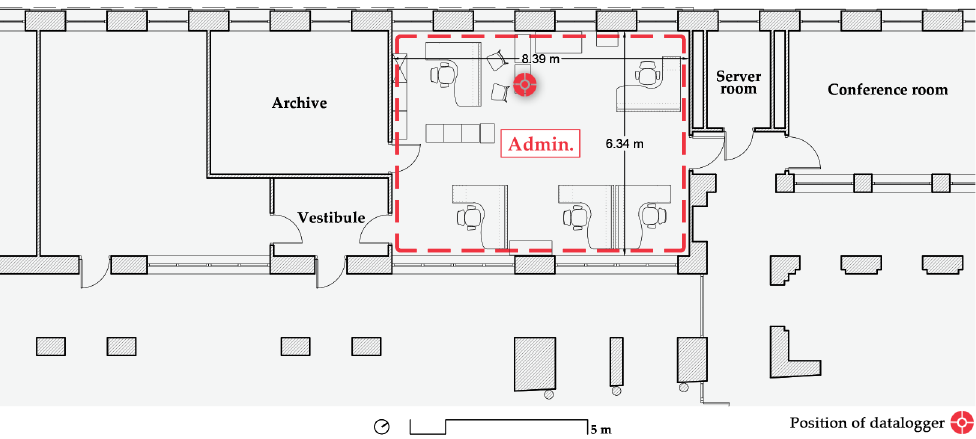
Figure 7. Floorplan of the monitored administration office on the ground floor. Source: authors.